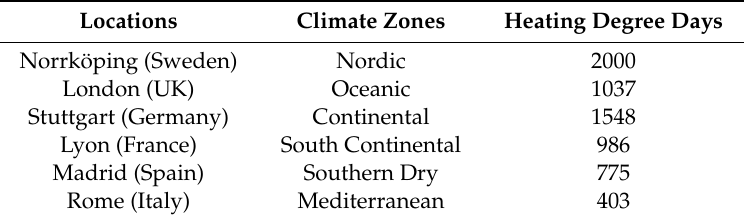
Table 4. Examined climates for the simulation